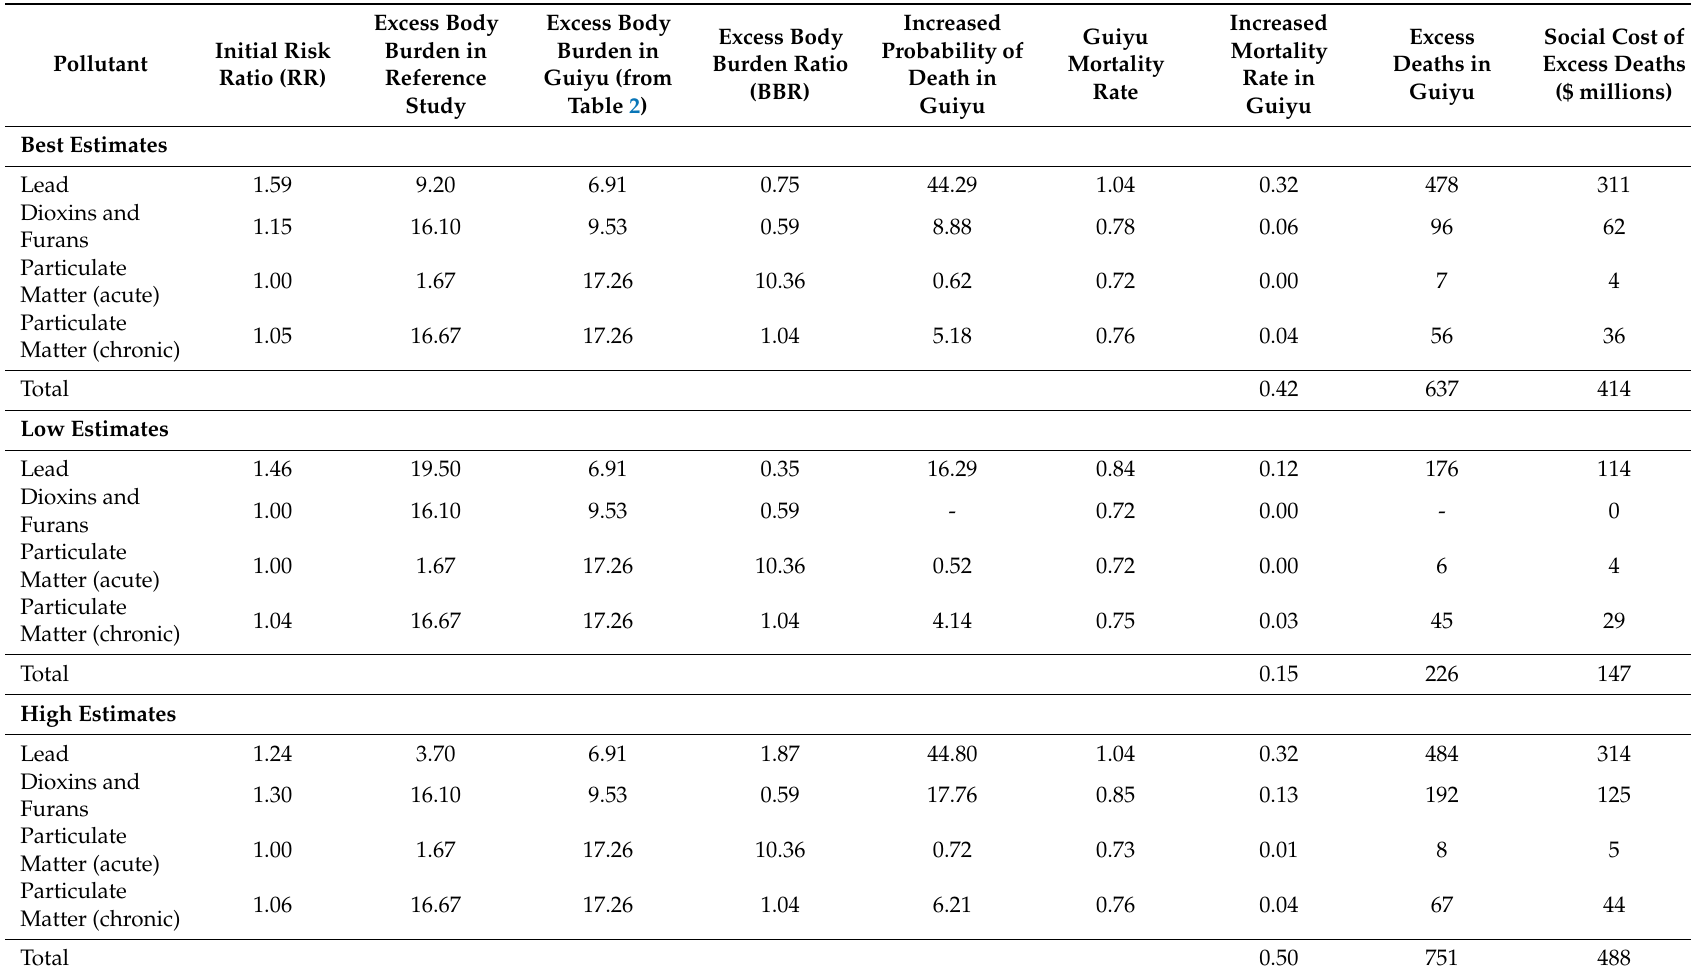
Table 3. The Number and Social cost of Excess Deaths from e-waste in